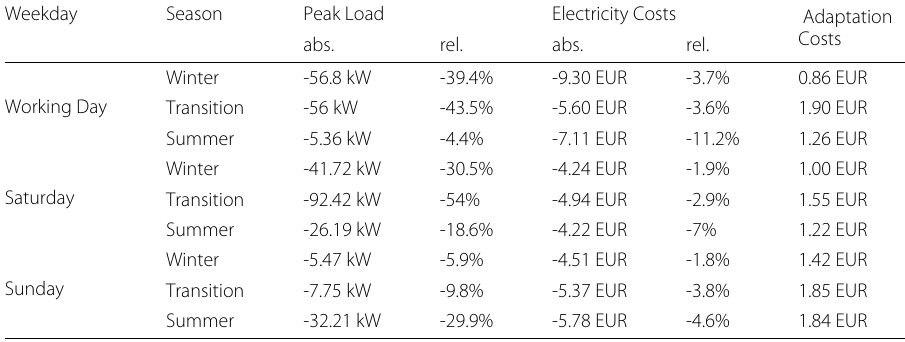
The reduction of the load peaks works differently well, depending on the type of the peak. Negative load peaks due to the feed-in of photovoltaic systems can hardly be reduced. The reason for that is that there is usually only little flexibility available during the period of feed-in within the smart buildings. Additionally, the existing flexibility is often associated with high adaptational effort and hence very costly. Another reason for Table 1 Effect of the optimization regarding the multiple objectives for the different simulated days in the rural